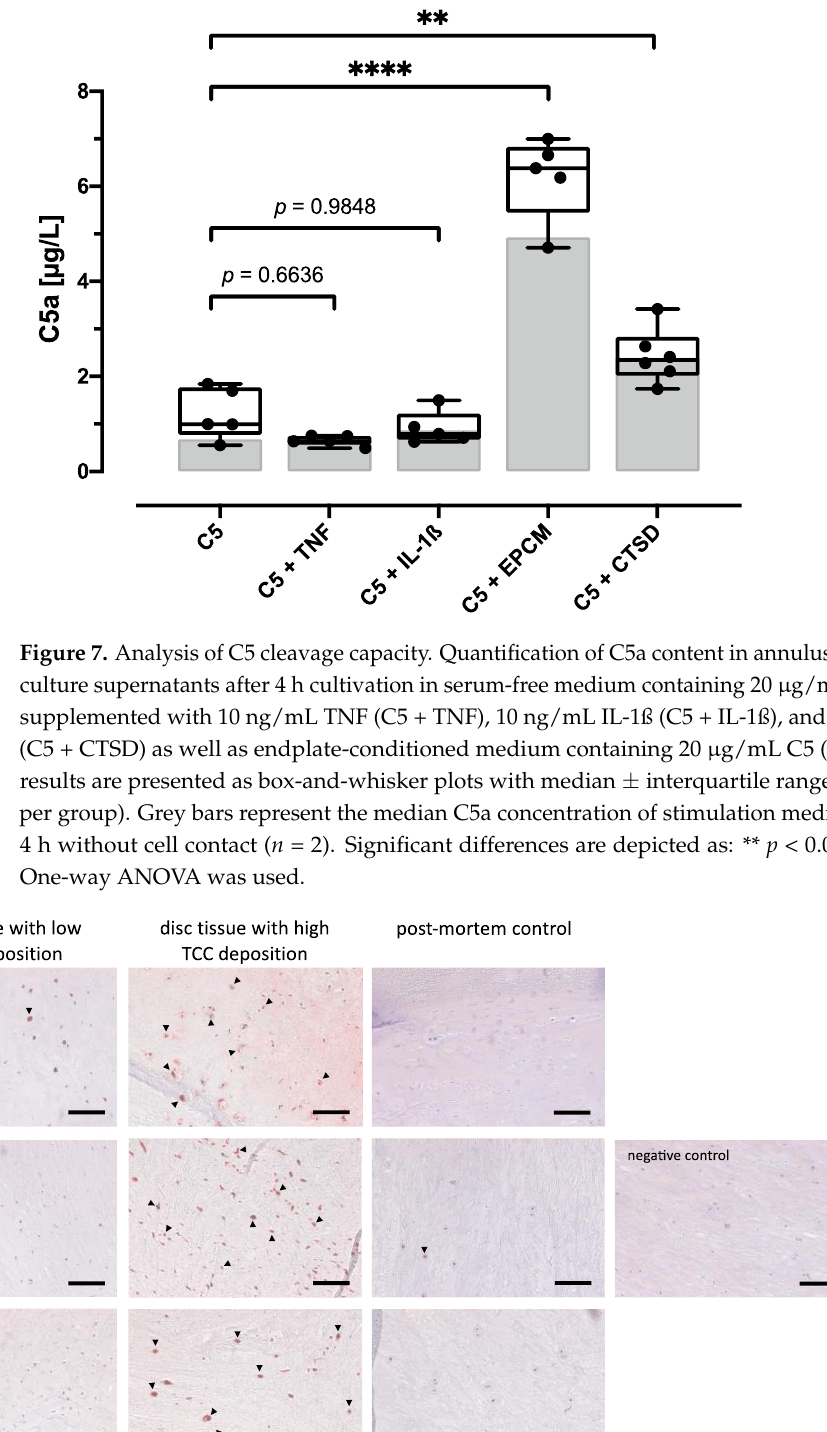
Figure 8. Immunohistochemical staining of cathepsin D (CTSD). Representative images of immune histological staining of CTSD in degenerated IVD tissue with remarkably high respective low TCC deposition, as well as macroscopically non-degenerated IVD tissue of a control donor collected post-mortem (60 years old, female) in the three different IVD regions (endplate (EP), annulus fibrosus (AF), and nucleus pulposus (NP)) and a representative negative control of the staining. CTSD-positive cells are indicated by arrowheads as examples. Scale bar: 100 µm.